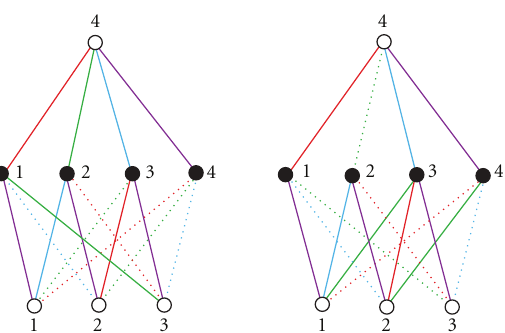
Figure 2: The two 3-4-1 Adinkras obtained from the Valise Adinkras in Figure 1 by raising one vertex. Here we have raised the boson vertex labeled